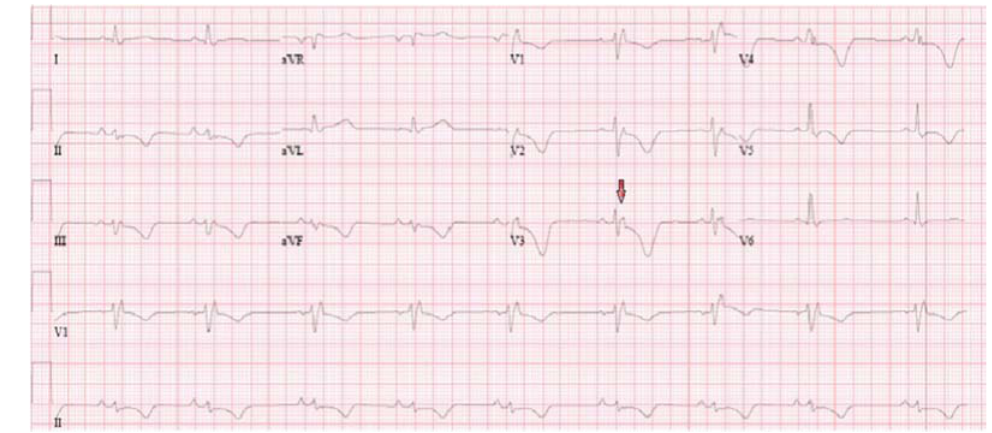
Figure 5. 12 Lead ECG of arrhythmogenic cardiomyopathy. Note the “epsilon wave” in V 3 , the right pericardial leads localized QRS prolongation which is mainly due to a terminal activation delay (from nadir of S to the end of QRS complex), and T wave inversion in V 1-3